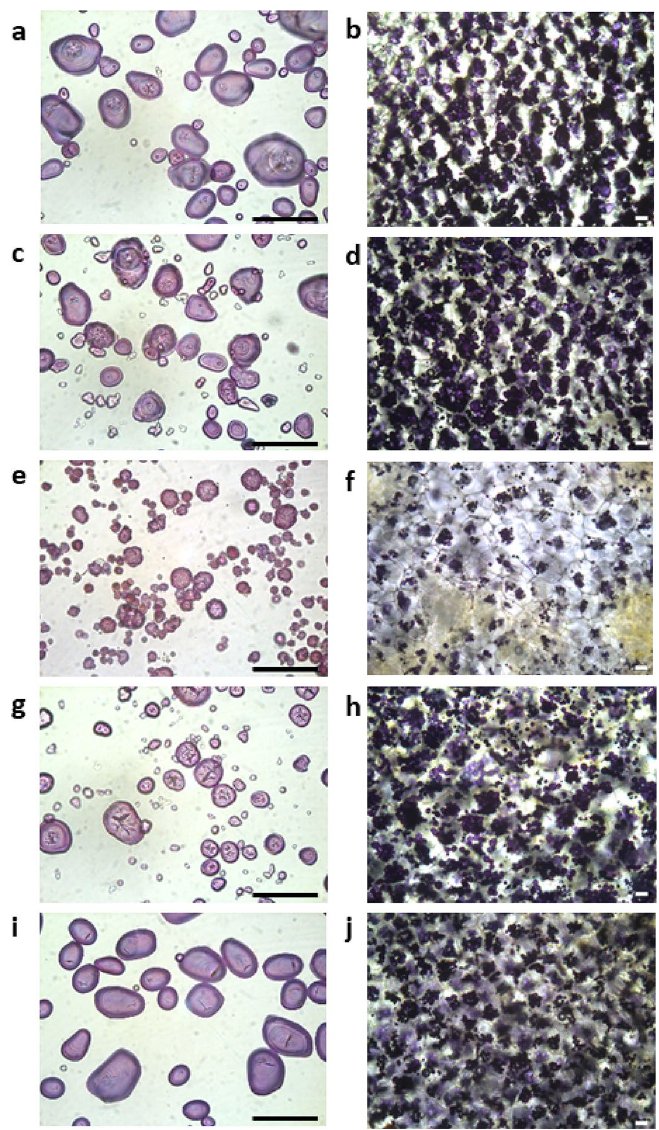
Figure 6. Starch granules (left images) and thin sliced tuber tissue (right images) stained with iodine and visualised under light microscope. ( a , b ) 82079 (Group 1) ( c , d ) 104018 (Group 2) ( e , f ) 104010 (Group 3). ( g , h ) RNAi line T-2012. ( i , j) parental variety Desiree. Scale bar = 100